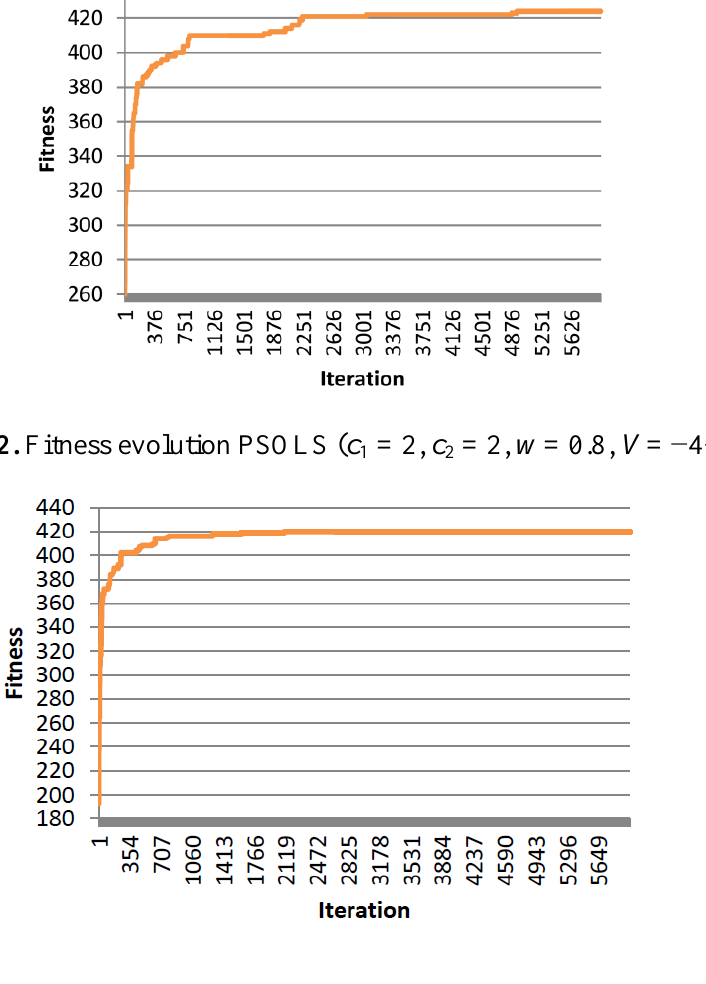
Figure 11. Fitness evolution of SPSOLS ( c